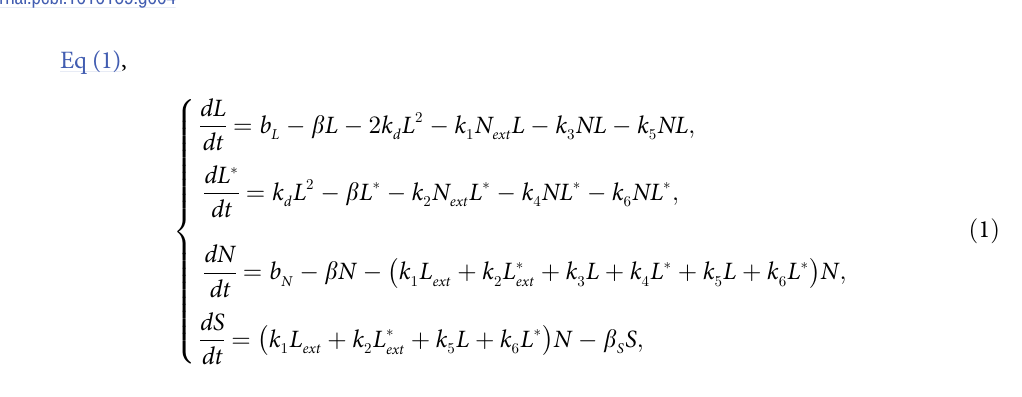
Fig 4. (A) Luciferase reporter assays were performed as described in the Methods. Upper graph: U2OS cells co-expressing Notch activity luciferase reporter together with the indicated Notch2 and ligand constructs (cis cells) were co-cultured with cells stably expressing DLL4 (to enable transactivation). Mutant DLL4 Δ 8 does not cis-inhibit Notch activity significantly (p-value > 0.005) whereas other ligands do (p-value < 0.005). Middle panel: The same set-up as above, however, cells were cultured in the presence or absence of 10 μ M DAPT. Notch (-) means the absence of DAPT. DAPT blocks Notch activity significantly (p-value < 0.005) and then cis-ligands do not show inhibition effect further (p-value > 0.005). Lower panel: Cells expressing Notch2 and a Notch activity luciferase reporter were separately co-cultured with cells stably expressing the indicated DLL4 constructs. Mutant DLL4 Δ 8 trans-activates Notch activity significantly (p-value < 0.005) and has no significant difference in trans-activation of Notch from other ligands (p-value > 0.005). For each analysis, reporter activity was normalized using Renilla luciferase. Levels of ectopically expressed proteins were determined by Western blotting of cell lysates. Each condition in each experiment was performed in triplicate and error bars represent the standard deviation of the mean. Experiments were performed three times. Representative experiments are shown. (B) Immunofluorescence showing the sub- cellular distribution of wild type and mutant DLL4 ligands. The Golgi apparatus was visualized using a calnexin-specific antibody, to rule out aberrant accumulation of ligand.